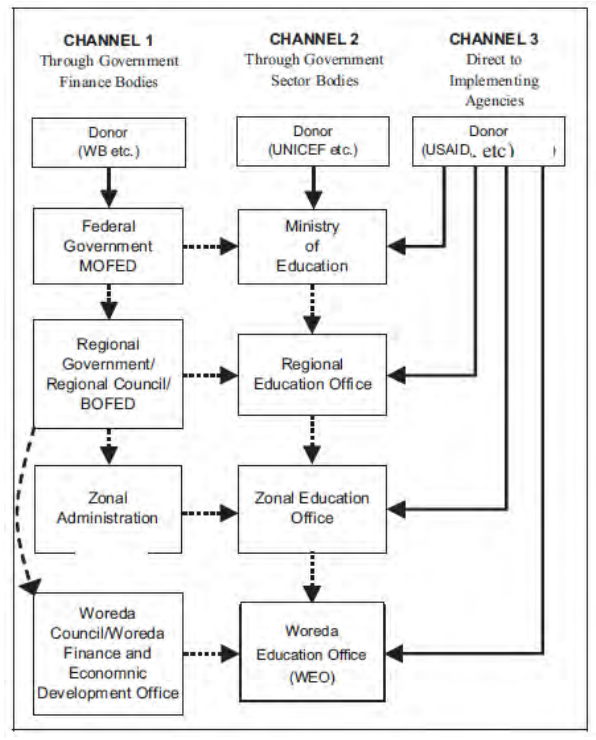
Figure 5-4: Types of Donor Disbursement